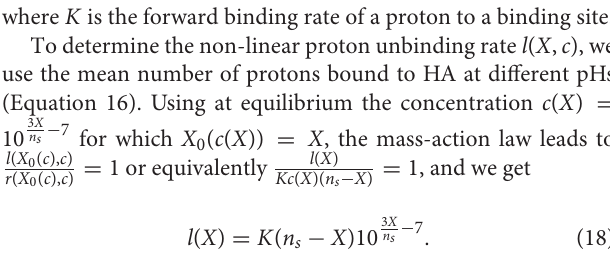
FIGURE 2 | Endosomal acidification. The kinetics of acidification obtained with intracellular fluorescence microscopy (red line. Mean with coarse-grained modeling (Equation 6, black line. Model parameters are summarized in Table 1